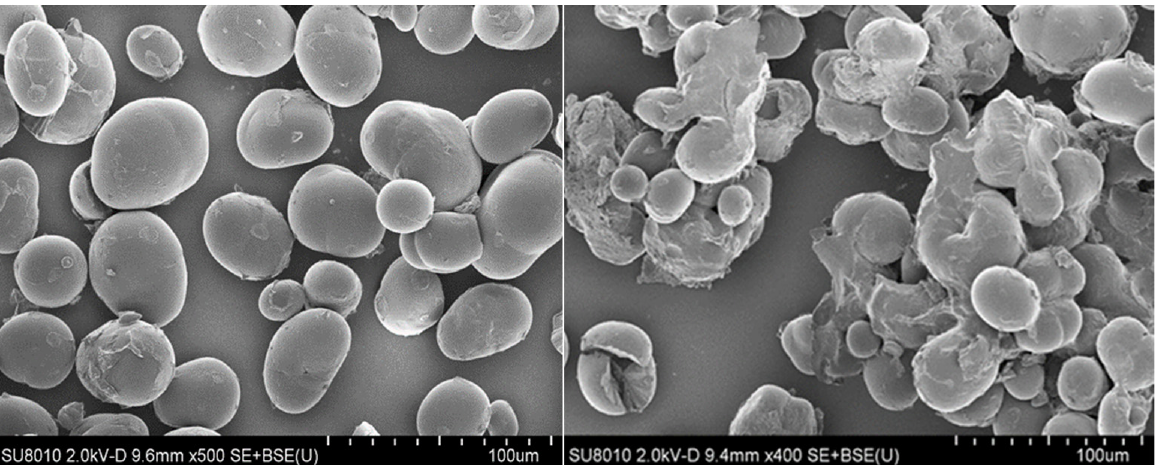
Figure 4. SEM pictures of adzuki bean starch at the magnification (100 × ). CK is shown on the left, MT is shown on the right.